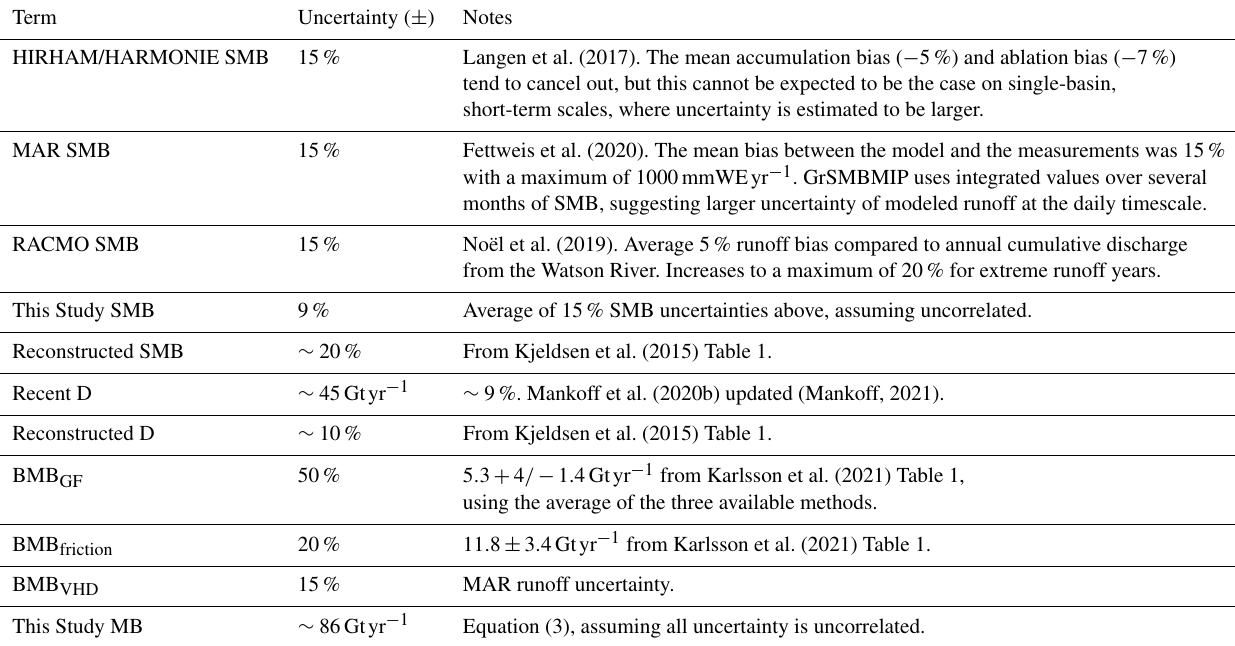
Table 3. Summary of uncertainty estimates for products used in This Study. This is an approximate and simplified representation – RCM uncertainties are calculated separately for gain and loss terms, because SMB near 0 does not mean uncertainty is near 0. This is also why the final This Study uncertainty is presented with units Gtyr − 1